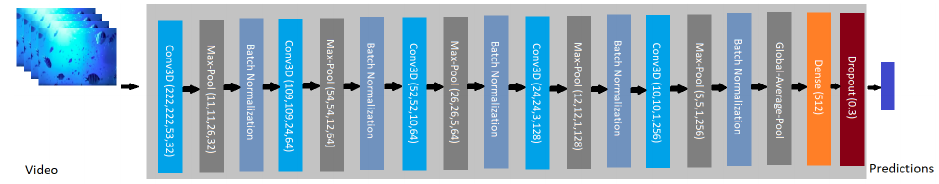
Figure 5. Architecture of the customized 3D-CNN designed to detect anomalies in video